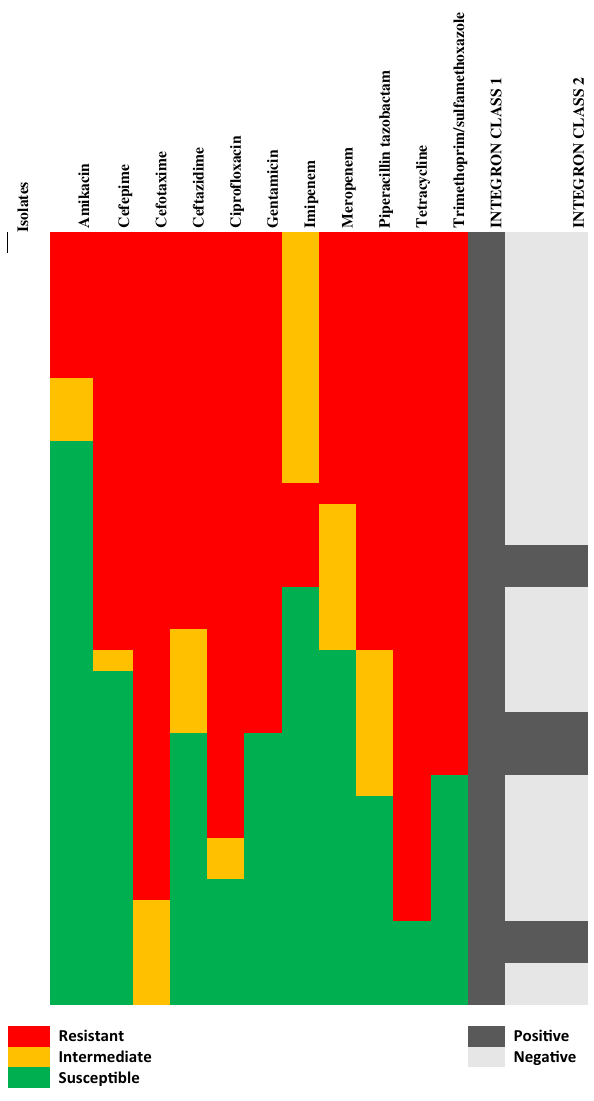
Figure 3. The heat map representing correlations among antibiotic resistance profile in Acinetobacter baumanni and integron type.